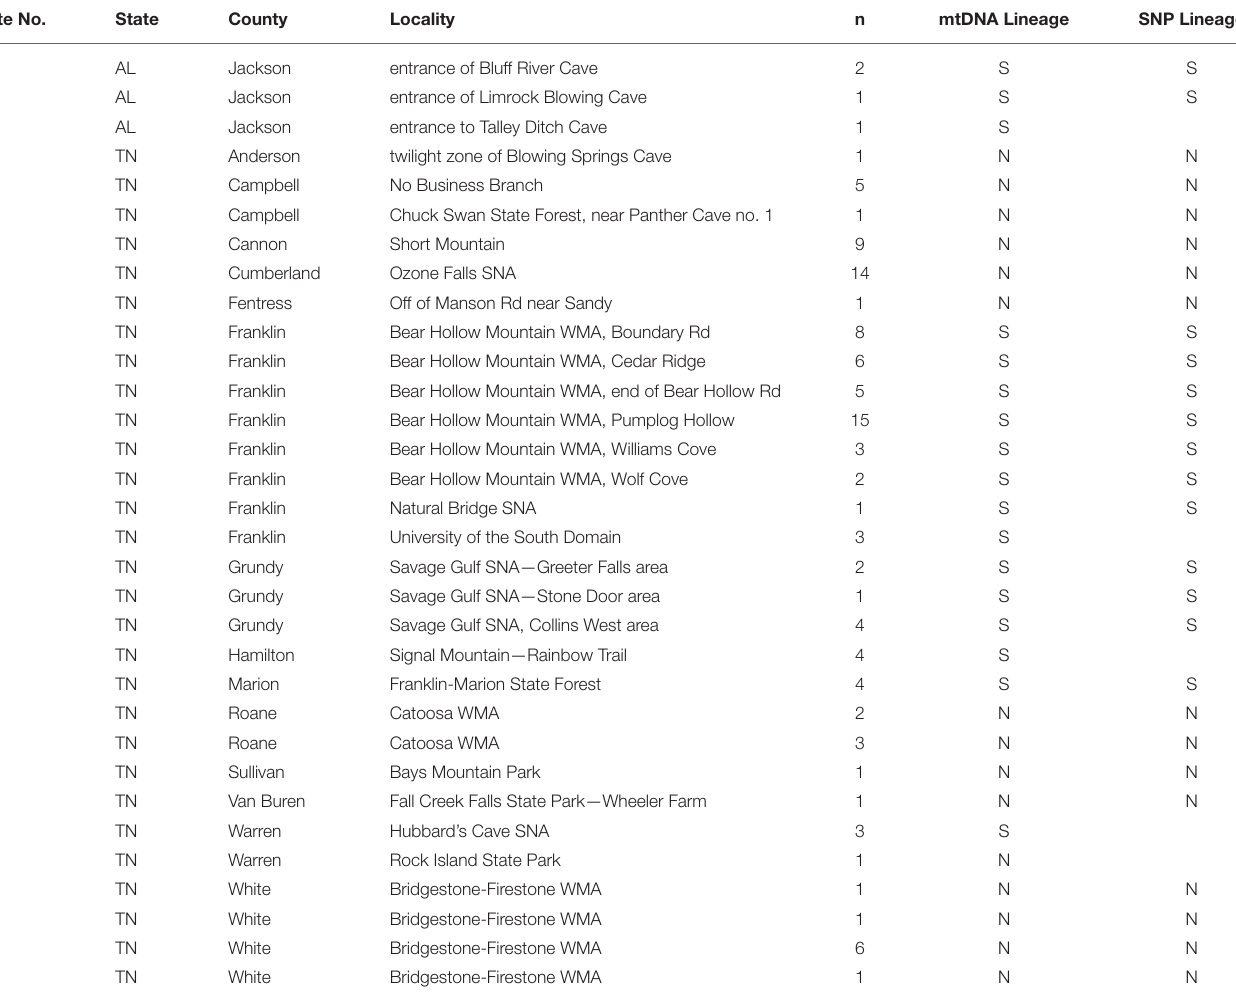
TABLE 1 | Sites of Aneides aeneus sampled in Tennessee and northeastern Alabama for genetic and genomic analyses, including site information, number of individuals (n) sampled from each population, and primary group assignment for mtDNA ( nd4 and cytb ) and nuclear SNP analyses based on fastStructure, DAPC, and IQ-TREE (N = northern lineage; S = southern lineage). Site